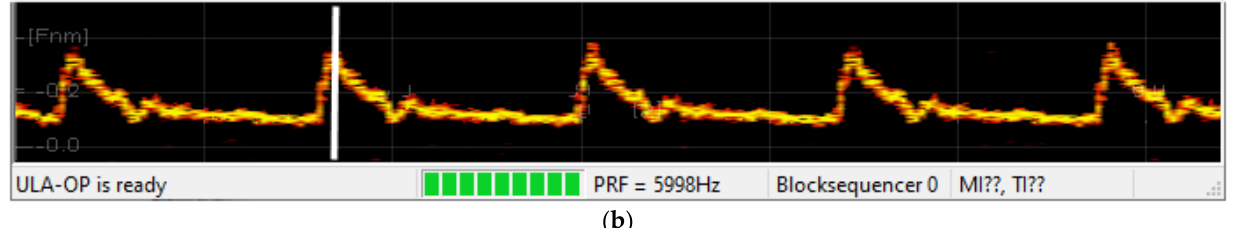
Figure 5. Screenshot of the real-time echograph display showing the sonogram ( a ) and the spectral profile ( b ) corresponding to the Doppler signal emulated by the proposed coprocessor. The power of the Doppler spectrum is represented in colors from red (low power) to yellow (high power). The sonogram refers to the middle-vessel depth, highlighted by the white line in the profile.